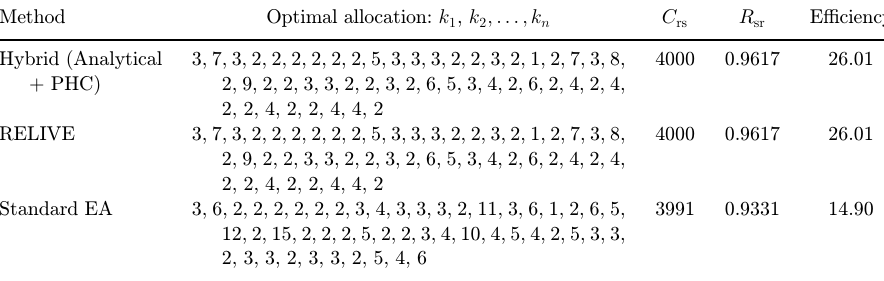
Table 3. The best solutions found by the considered methods: Experiment I, Problem 2.